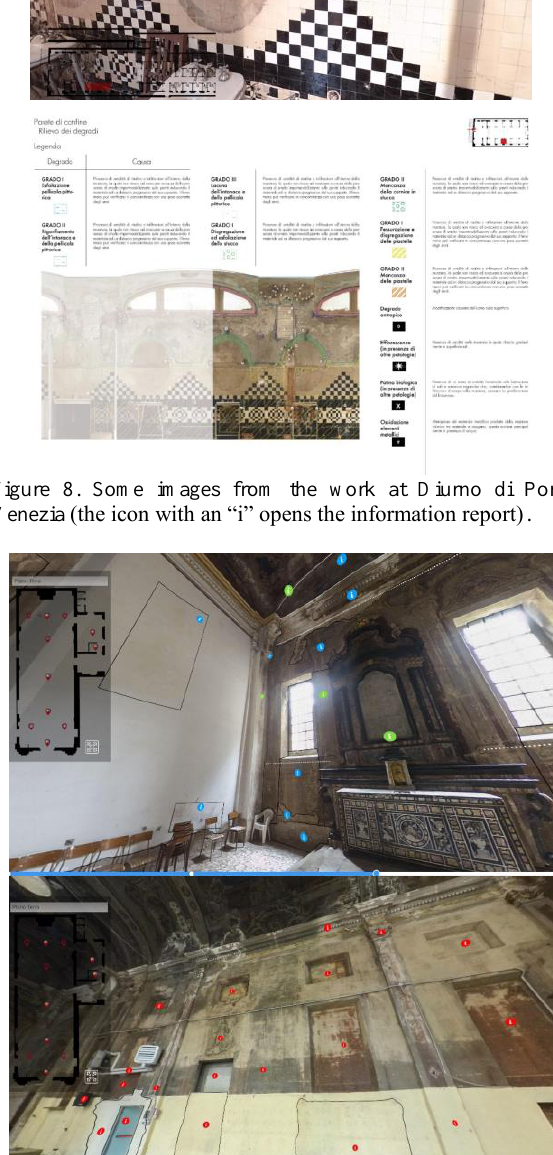
Figure 10. Example of image rectification with 360°